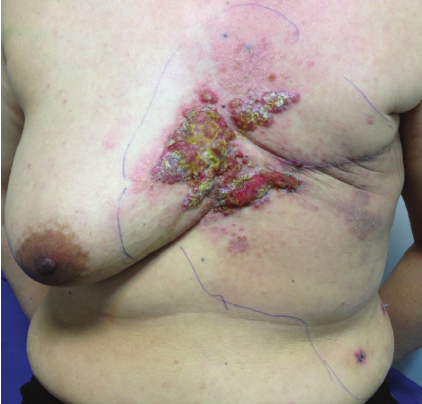
Figure 1: Indurated erythematous ulcerative papulonodular pla- que appearance lesion on the previous MRM